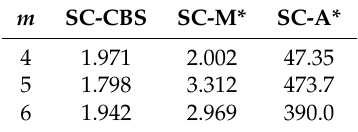
Table 4. Average run time of SC-based MAPP solvers in the one-resource-one-type context. m SC-CBS SC-M* SC-A* 4 1.971 2.002 47.35 5 1.798 473.7 390.0